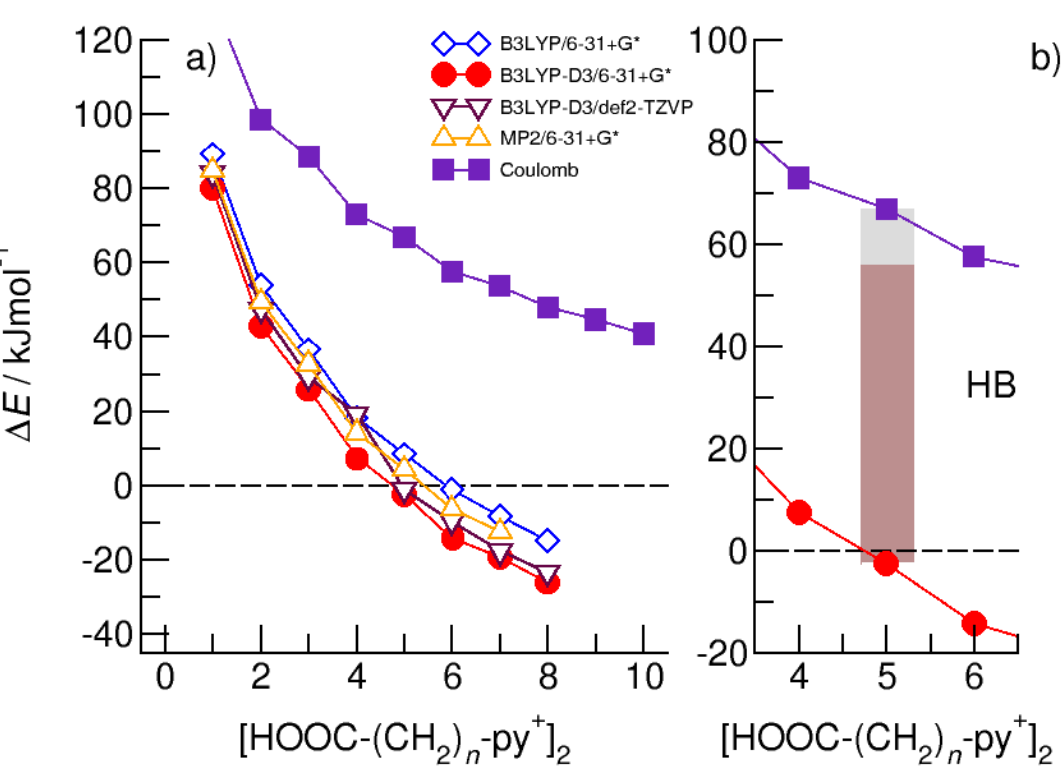
Figure 5. ( a ) The binding energies for the cationic dimers (HOOC − (CH 2 ) n − py + ) 2 with n = 1–8, as calculated at the dispersion-corrected B3LYP–D3/6–31+G* level of theory (filled circles). For comparison, we added the calculated binding energies obtained at the B3LYP/6 − 31+G* (diamonds), the B3LYP–D3/def2–TZVP (triangles down), and the MP2/6–31+G* (triangles) levels. The filled squares show the long-range e 2 / R behavior of idealized Coulomb electrostatic repulsion assuming positive charges q = +1 on the centers of the two pyridinium rings as obtained by Mulliken population analysis. ( b ) For the cationic dimer (HOOC–(CH 2 ) 5 –py + ) 2 , the Coulomb repulsion is more than counterbalanced by the attractive hydrogen bond and dispersion forces, resulting in slightly negative ∆ E = − 2.51 kJmol − 1 (filled circles). The energy difference represents the sum of the H-bond ( ∆ E = − 58.5 kJmol − 1 ) and dispersion energy ( ∆ E = − 10.9 kJmol − 1 ), as indicated by the brown and grey bars, respectively.